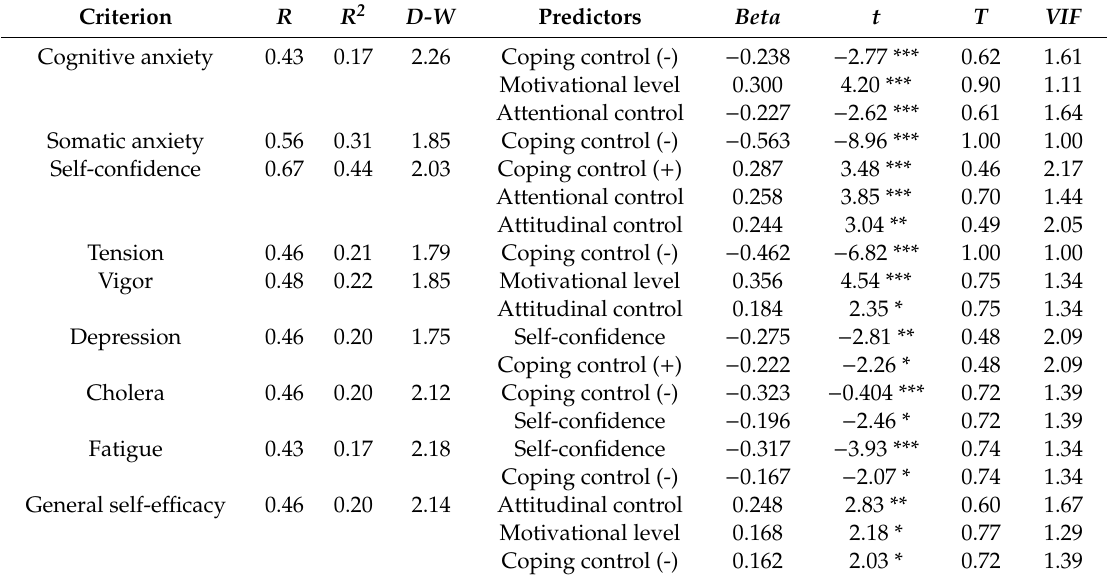
Table 4. Linear regression analysis (successive steps) for the total sample.